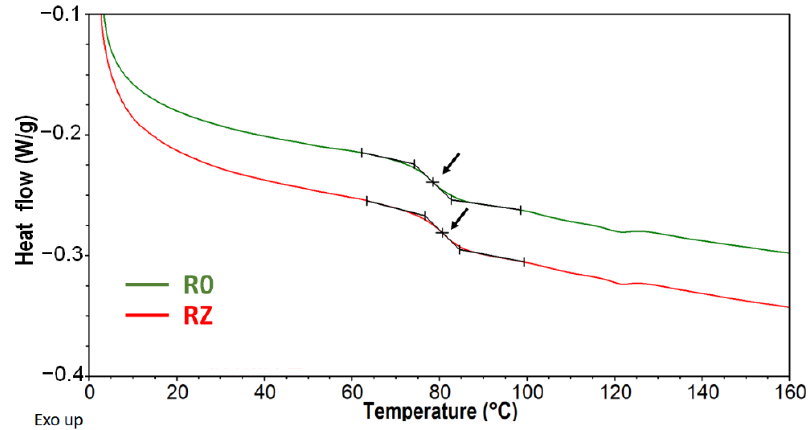
Figure 4. DSC curves obtained for RO and RZ composite materials (arrows point the glass transition).